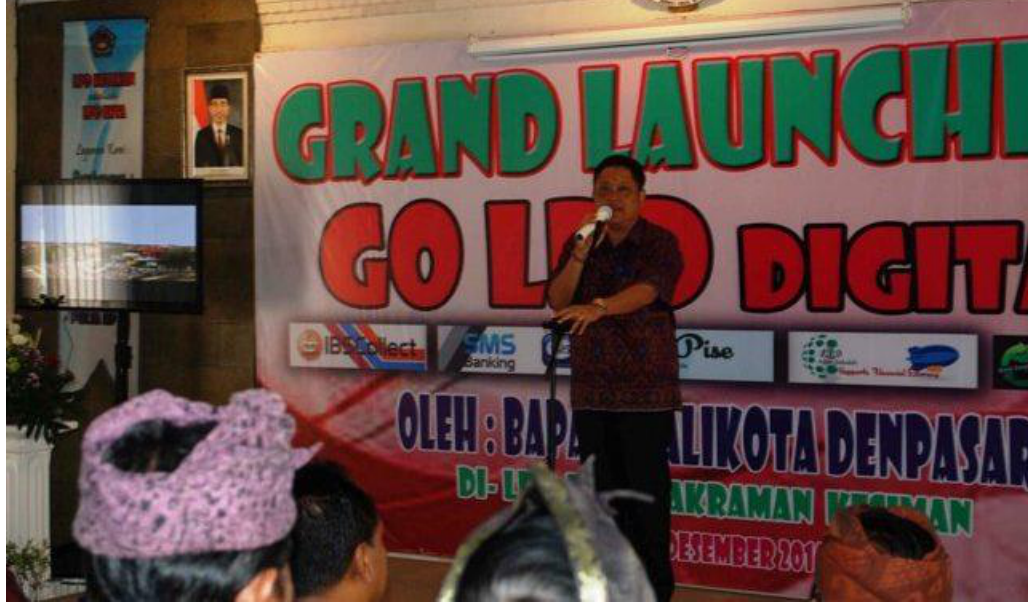
Fig. 3 : Rai Mantra, Denpasar Mayor When Launching LPD Kesiman Go Digital; source: